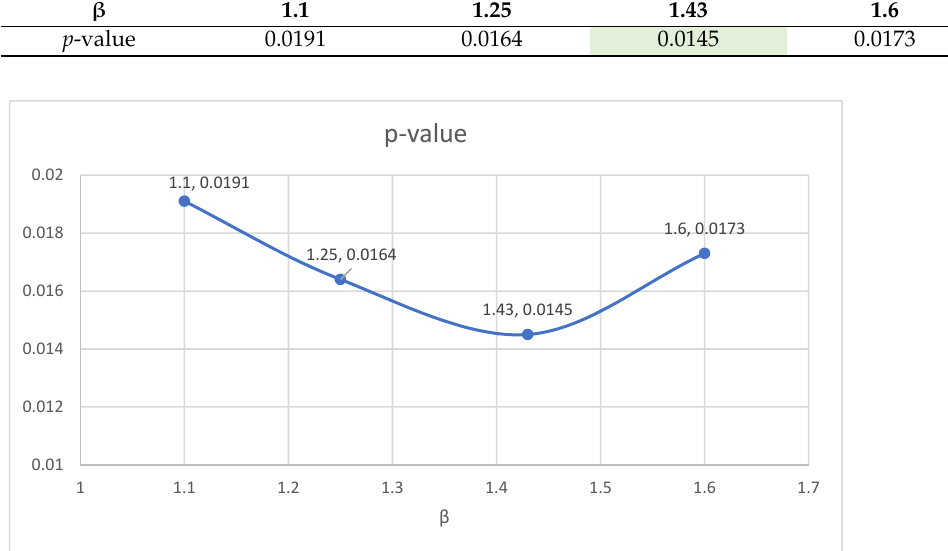
Figure 5. p -value results when β varies from 1.1 to 1.6 under the DDAA.